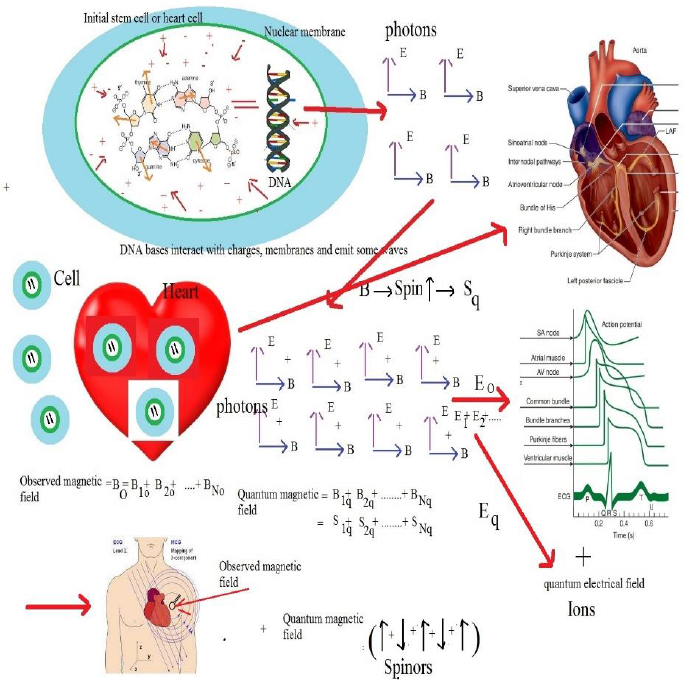
Figure 3. The process of formation of different frequencies of electrical and magnetic fields and their related spinors by the heart—a hypothesis.